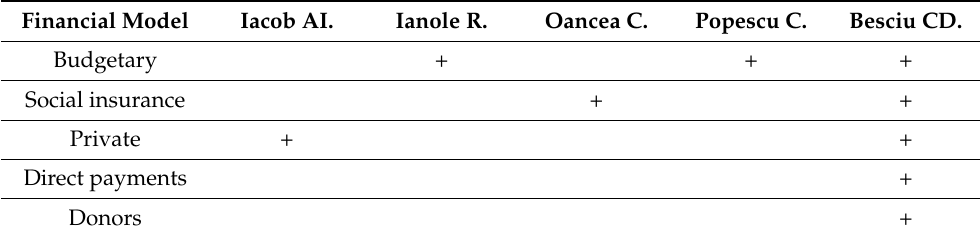
Table 4. Romanian author’s positions on the choice of the most effective system.